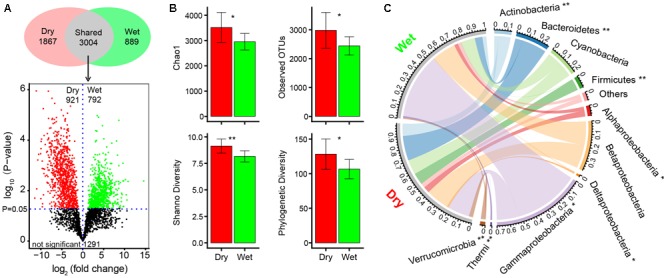
Basic differences of bacterial communities between dry-season and wet-season. (A) Venn diagram showing the unique and shared OTUs in dry-season and wet-season. The volcano plot showing the shared OTUs that significantly (t-test, P < 0.05) enriched in dry-season (red dots) and wet-season (green dots). The volcano plot was constructed using log2 fold change on x-axis and –log10 p-values of t-test on y-axis. (B) Alpha diversity (Chao 1, observed OTUs, Shannon diversity, and phylogenetic diversity) of bacterial communities in dry-season and wet-season. (C) Chord diagram showing the relative abundances of dominant phyla (the phyla with a relative abundance >1%) in dry-season and wet-season. “Others” represents the unsigned OTUs and the phyla with a relative abundance <1%. Statistical significance between dry-season and wet-season was assessed by t-test and indicated by asterisks (∗represents P < 0.05, ∗∗represents P < 0.01).